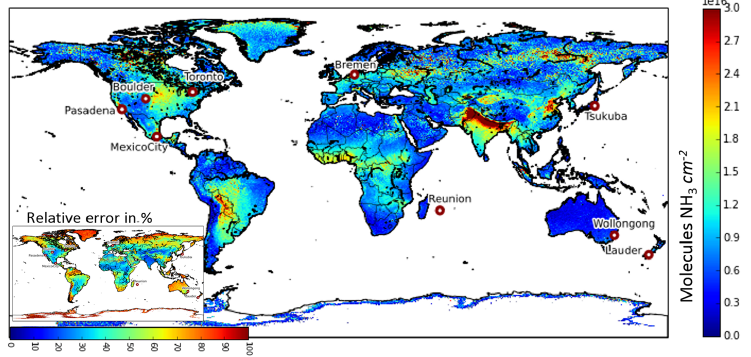
Figure 1. Mean IASI-NH 3 total column distribution for the period between January 2008 and January 2015. The total columns are a weighted average of the individual observations weighted with the relative error. Red circles indicate the positions of the FTIR